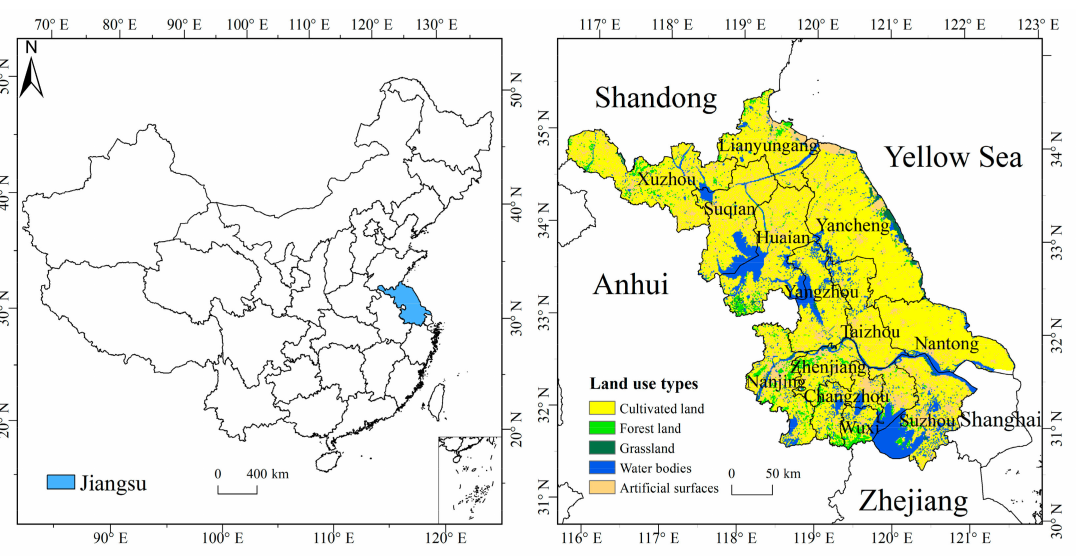
Figure 1. Location of Jiangsu Province in